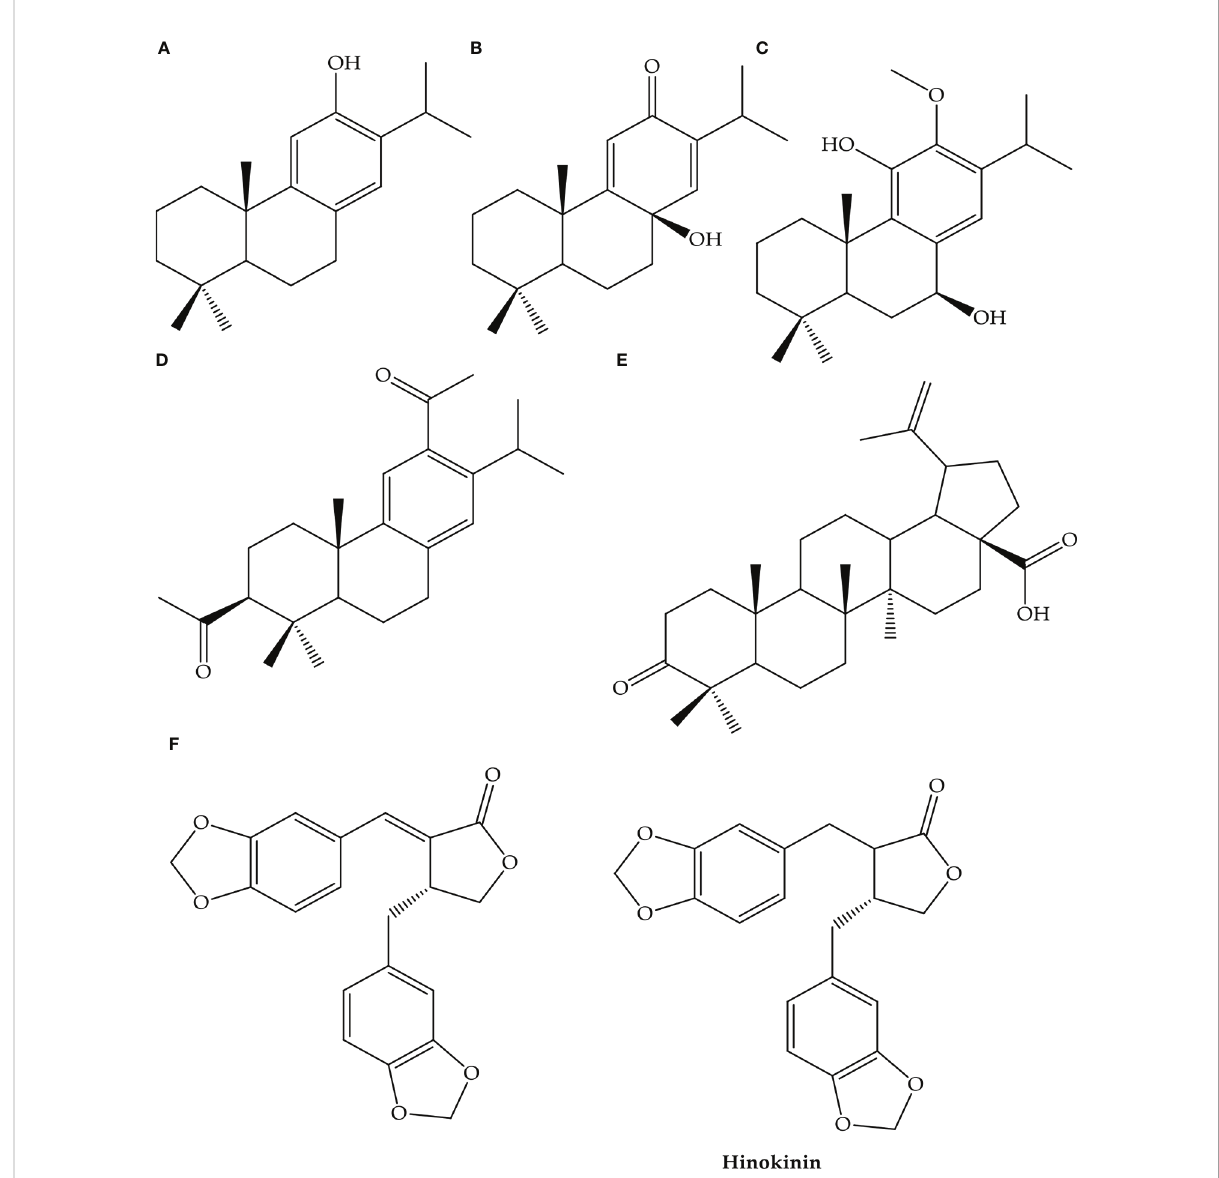
FIGURE 2 Natural derivatives with antiviral activity against SARS-CoV- 1. Ferruginol (A) , 8 b -hydroxyabiet-9(11),13-dien-12-one (B) , 7 b - hydroxydeoxycryptojaponol (C) , 3 b ,12-diacetoxyabiet-6,8,11,13-tetraene (D) , betunolic acid (E) , and savinin (F) (Prasansuklab et al.,